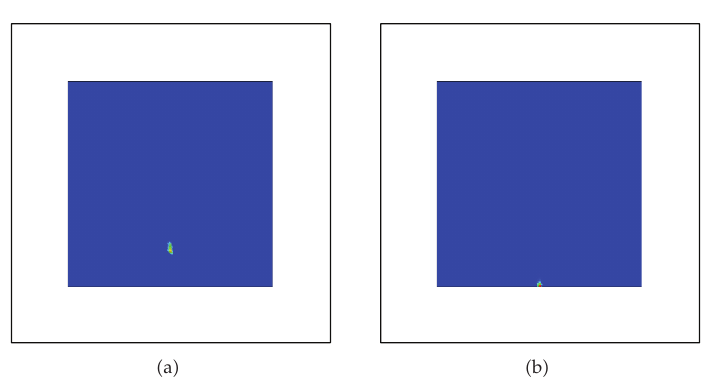
Figure 8: One point source at (cid:2) 50 , 20 (cid:3) with 25 time steps, full concentration is given in red and zero concentration with blue.